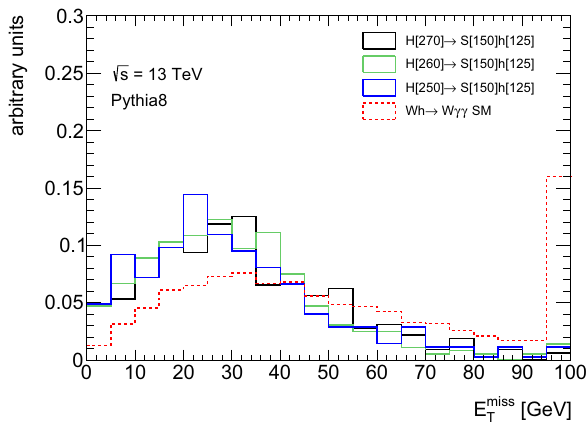
Fig. 7 Missing transverse energy in events with two photons and one electron or muon for several H → Sh samples (solid lines) compared with the SM Wh process with h → γγ (dashed line) generated with PYTHIA8 . The last bin contains overflow events